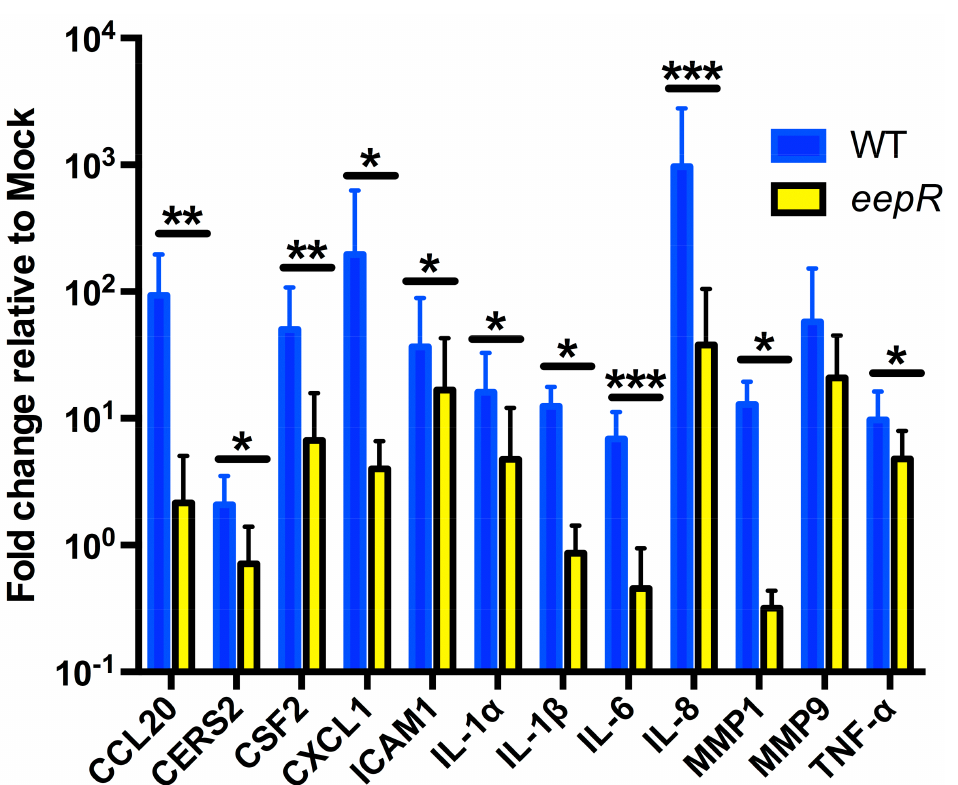
Figure 1. qRT-PCR of pathway markers confirmed microarray analysis. Graph represents the fold change in gene expression relative to mock (LB) treatment. HCLE cells were exposed to LB, WT, and eepR transcriptomes of 5 h. Gene expression was normalized to GAPDH expression. Means (n = 4–8, n = 3 for IL-1 α ) and SD are shown. ∆∆ CT values were compared by ANOVA with Bonferroni’s post-test, one asterisk (*) indicate p < 0.05, two indicate (**) p < 0.01, and three (***) indicate p < 0.001. Table 1. Twenty-five genes with the greatest expression increase in cells treated with WT vs. mock secretomes. Mean of Normalized Scaled Expression, Duplicates Expression Ratios